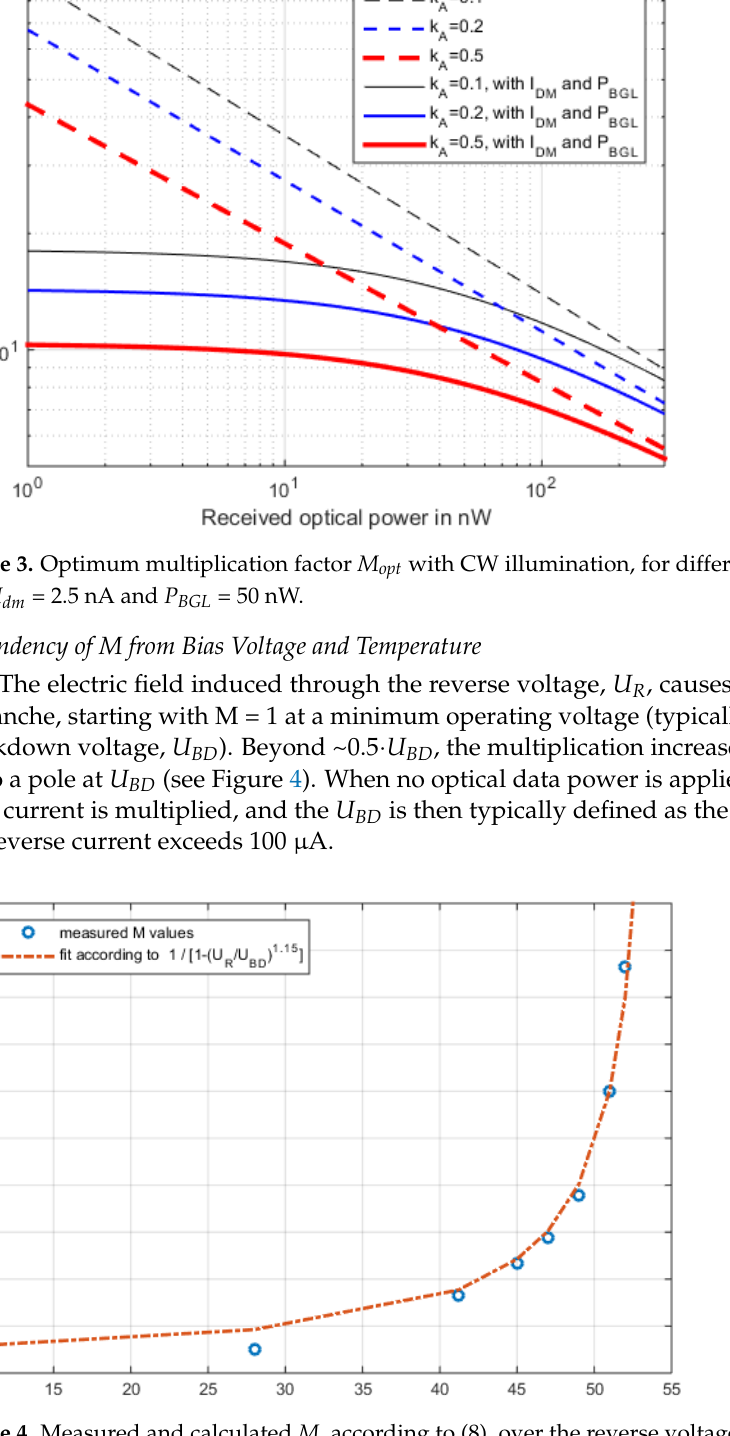
Figure 4. Measured and calculated M , according to (8), over the reverse voltage U R for U BD = 55 V and n = 1.15. The relationship between bias voltage, U R , and gain, M, is related by a simple ra- tional term [42,43]: